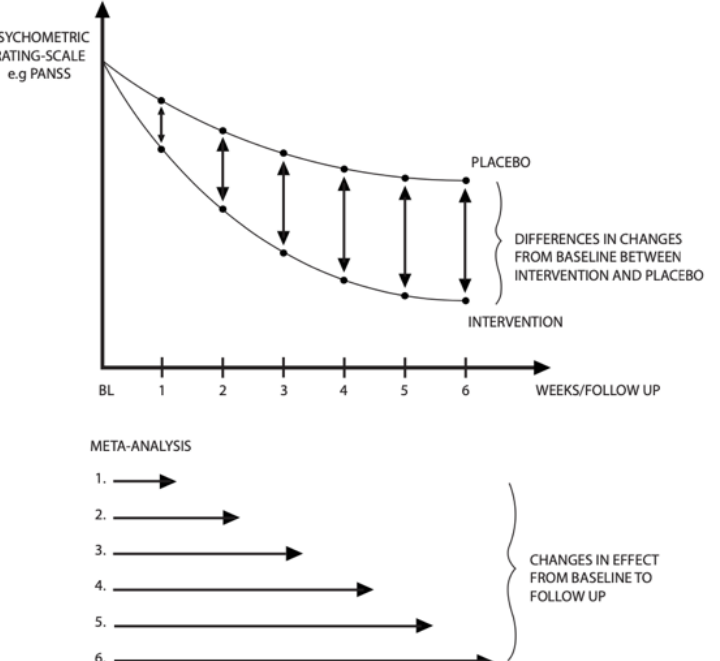
Figure 1. The top figure illustrates the difference in the changes of symptoms score from baseline to follow-up between intervention and placebo. The lower figure illustrates that separate meta-anal- yses were made for each